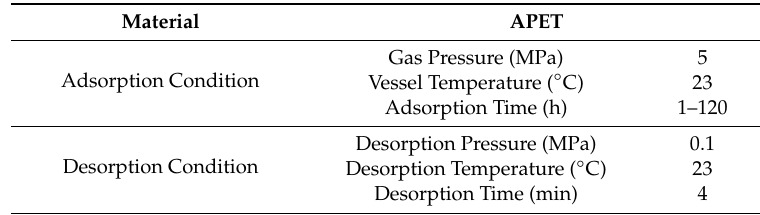
Table 1. Experimental conditions for studying changes in impact strength.